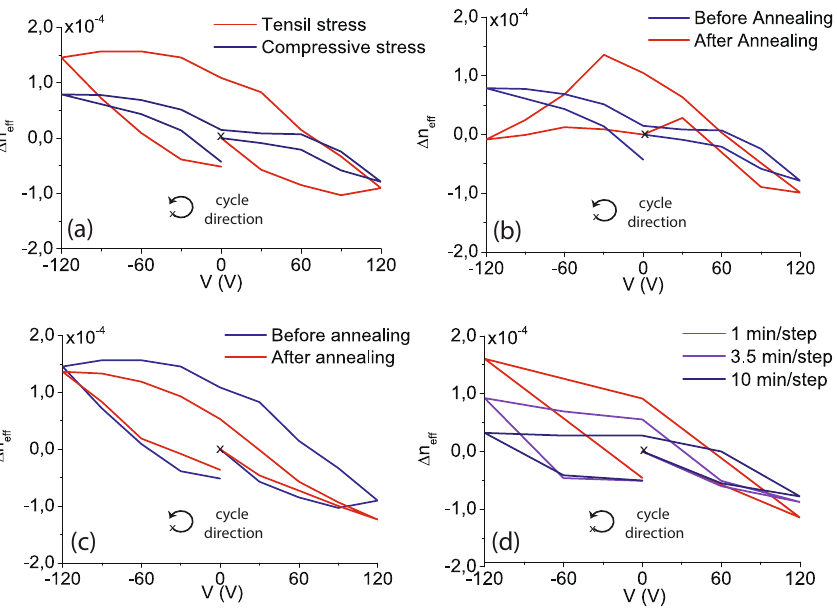
Figure 5. Experimental results for the compressive and tensile stress samples under different annealing and time measurement conditions. ( a ) Experimental refractive index change for the compressive and tensile samples before annealing. Comparison of results before and after the annealing for ( b ) the compressive and ( c ) tensile samples. ( d ) Results for the sample with tensile stress after annealing as a function of different times steps per each voltage measurement. The annealing process was performed at 500 °C during 30 minutes in atmospheric